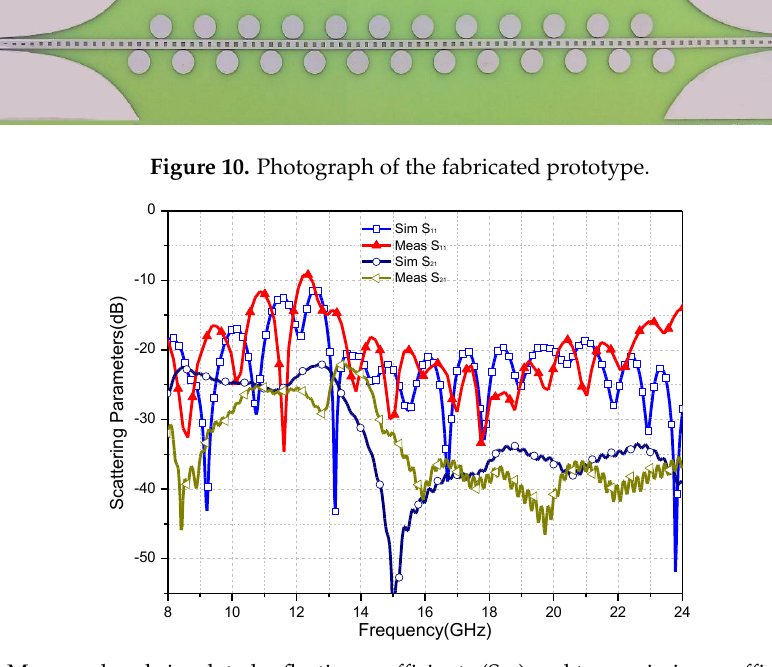
Figure 11. Measured and simulated reflection coefficients (S 11 ) and transmission coefficients (S 21 ) of the SSPP LWA.